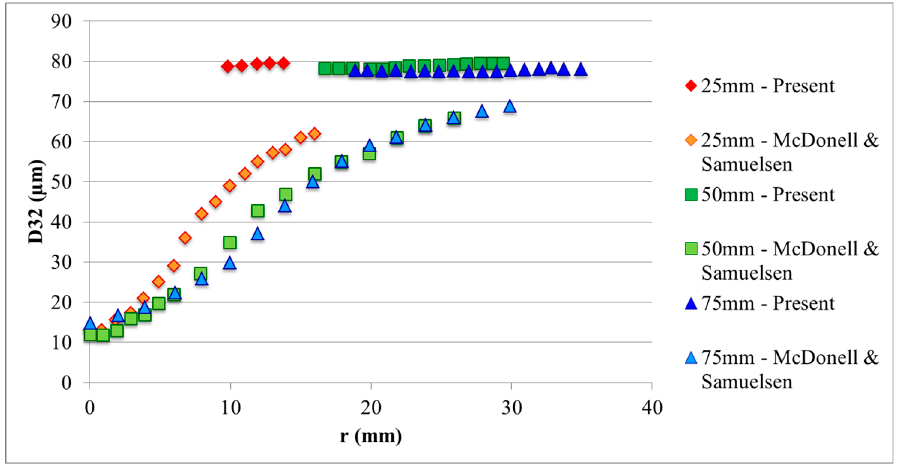
Figure 14. Sauter mean diameter of droplets at axial distances of 25, 50, and 75 mm with non-swirling atomizing air.